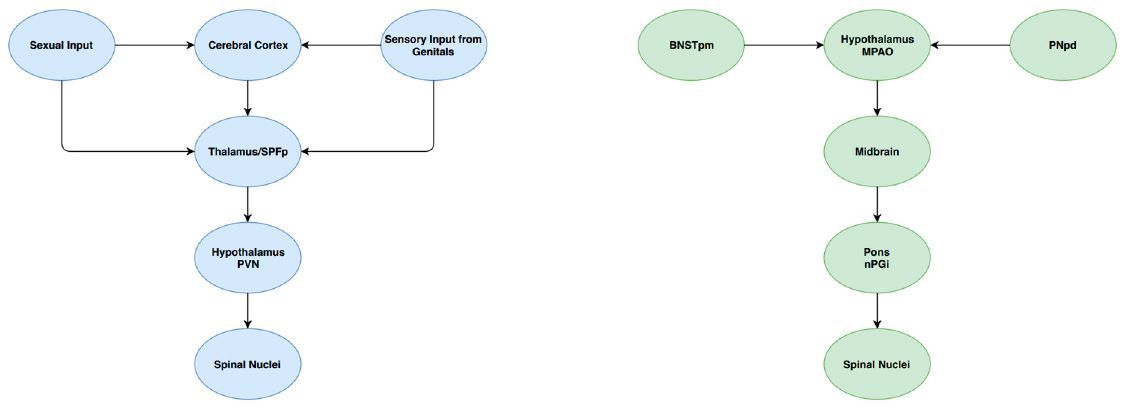
Figure 2. A schematic summary of some components of the central control of ejaculation.